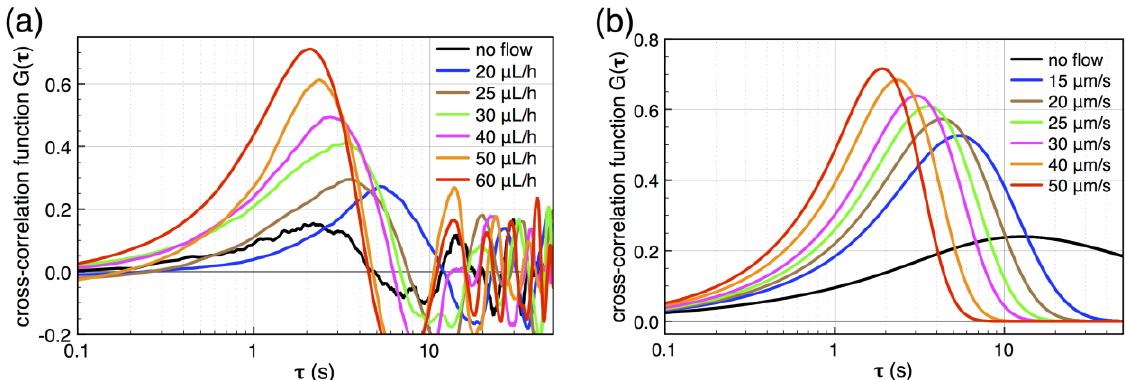
Figure 3. ( a ) Cross-correlation functions for different syringe pump flow rates determined from current-time traces recorded at both 100 μm long top electrodes of a 202 μm long nanofluidic device. ( b ) Analytically derived cross-correlation functions for different molecular drift velocities v for the same device geometry and an effective diffusion coefficient of D = 3.4 × 10 −10 m 2